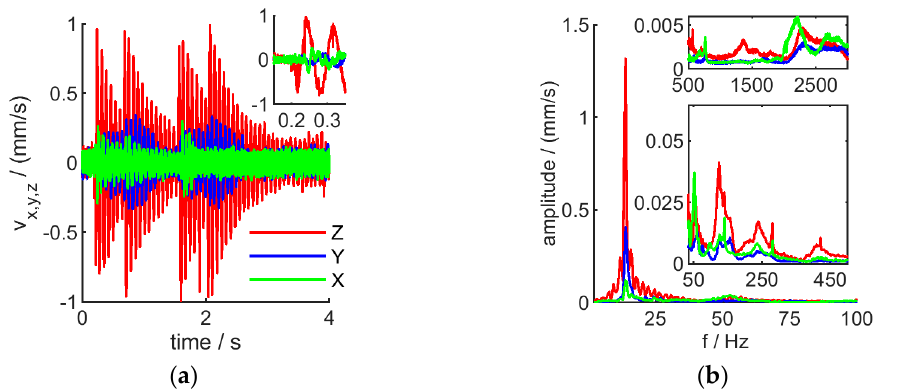
Figure 15. Velocity-traces ( a ) and dominant frequency components ( b ) of vibrations along the X , Y and Z axis, respectively, shown for H6 mounted on a fully extended robot arm.